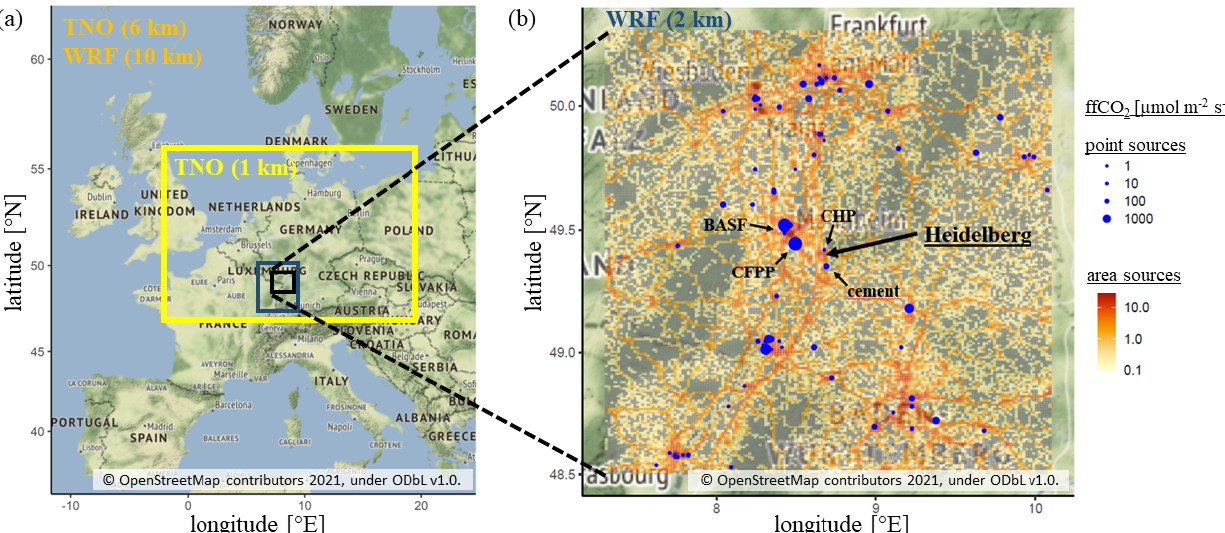
Figure 2. (a) Model domain and spatial resolution (in brackets) of nested WRF meteorological fields and TNO emission inventories. In the blue-grey box, TNO has a resolution of about 1km × 1km and WRF has a resolution of 2km × 2km. Outside the blue-grey box, the WRF resolution is decreased to 10km × 10km. Outside the yellow box the TNO inventory has a horizontal resolution of ca. 6km × 6km. Panel (b) shows a closer view of the Rhine Valley with the TNO area (orange) and point (in blue) source emissions shown (from Super et al., 2020). The observation site Heidelberg and the four closest point sources, i.e. a combined heat and power station (CHP), a cement production facility (cement), a coal-fired power plant (CFPP) and the BASF company in Ludwigshafen, are labelled. The Map tiles are by Stamen Design and used here under CC BY 3.0 (http://maps.stamen.com/terrain/, last access: 4 May 2022). The data are © OpenStreetMap contributors 2021 and distributed under the Open Data Commons Open Database License (ODbL)